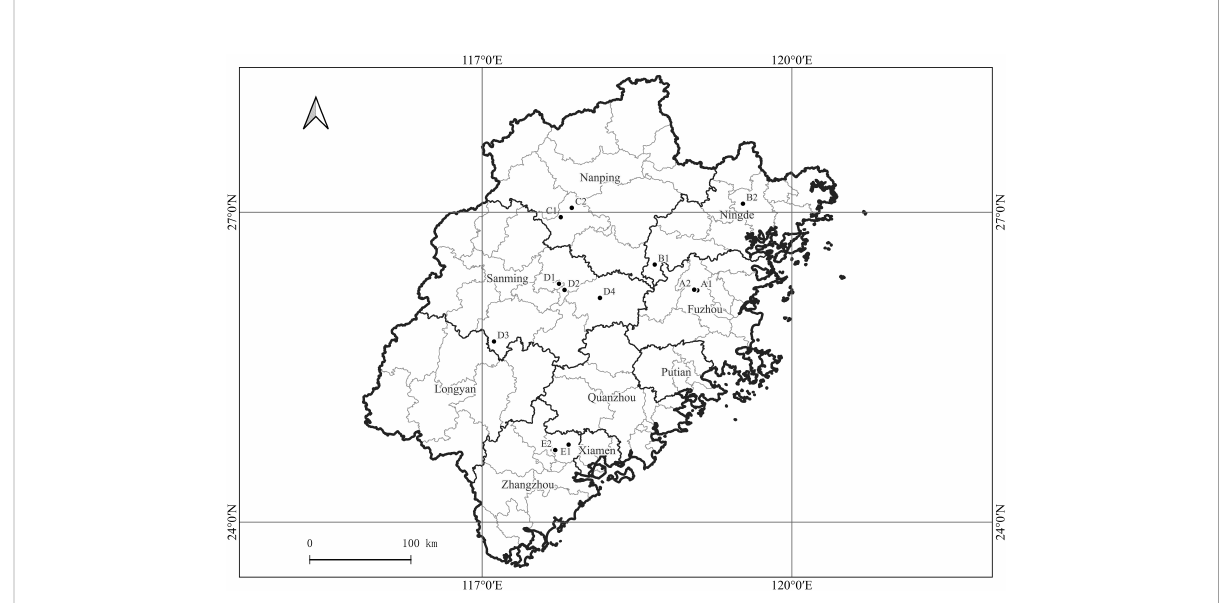
FIGURE 1 Geographical locations of citrus orchards in Fujian Province, China, from which plant images were acquired. A1, A2: Fuzhou (Navel orange, Citrus sinensis Osb. var. brasiliensis Tanaka); B1, B2: Ningde (Navel orange, C. sinensis Osb. var. brasiliensis Tanaka); C1: Nanping (Shatian pomelo, C. grandis var. shatinyu Hort); C2: Nanping (Ponkan, C. reticulate Blanc Ponkan); D1: Sanming (Shatangju mandarin, C. reticulata cv Shatangju; Orah); D2: Sanming (Satsuma mandarin, C. unshiu Marc.); D3: Sanming (Hongmeiren citrus hybrid); D4: Sanming (Ponkan, C. reticulate Blanc Ponkan); E1: Zhangzhou (Ponkan, C. reticulate Blanc Ponkan); E2: Zhangzhou (Ponkan, C. reticulate Blanc Ponkan; Tankan, C. reticulata var. tankan